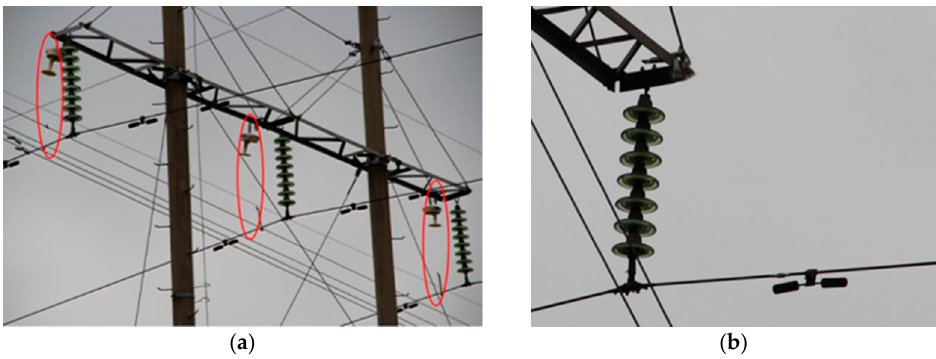
Figure 18. EAALPGs operating on 110 kV transmission lines. ( a ) An actual photograph of the installed 110 kV EAAGs. ( b ) A picture when the EAAGs are not installed.